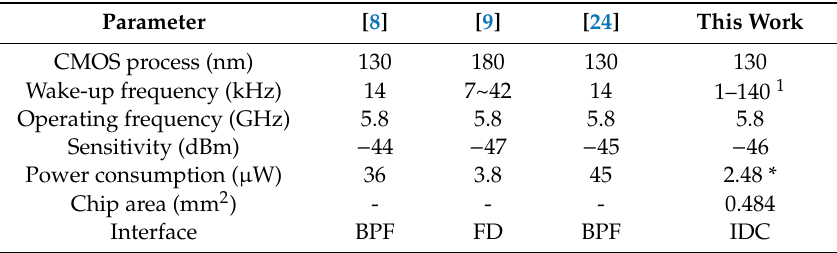
Table 3. WuRx performance